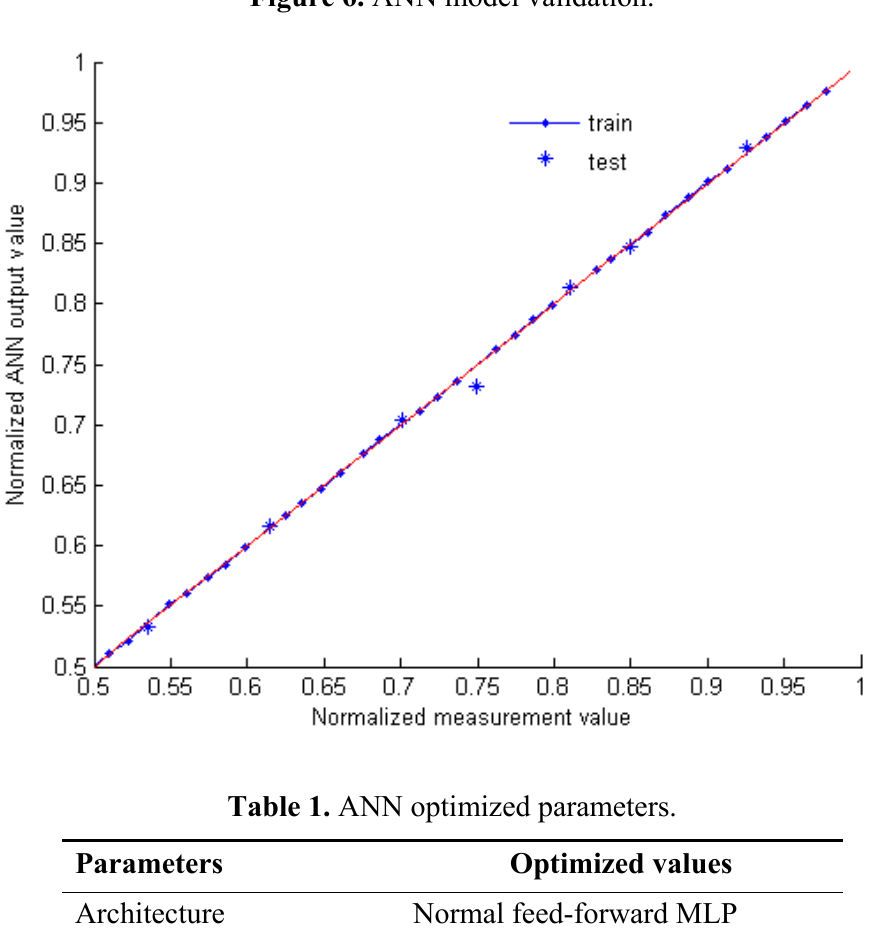
Figure 6. ANN model validation.